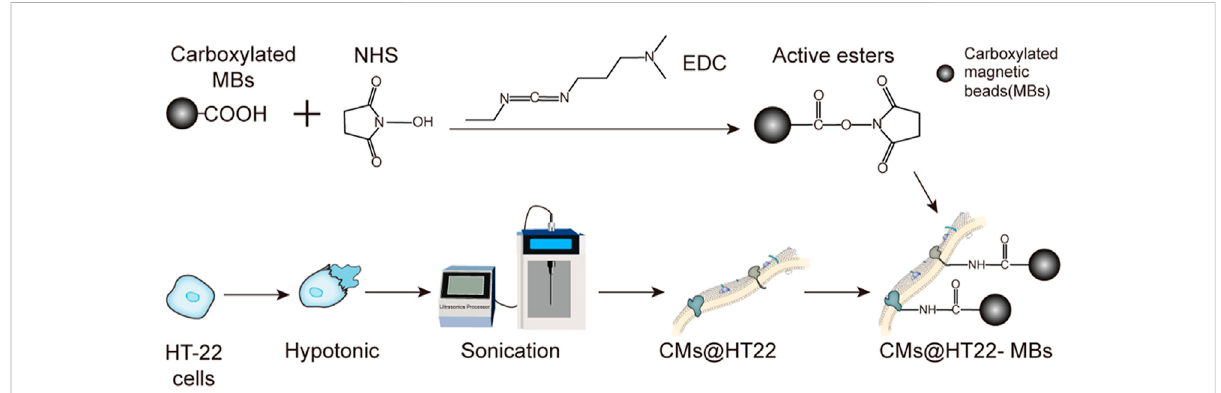
FIGURE 1 Preparation of membrane-coated magnetic beads (CMs@HT22-MBs). First, active esters were generated using the carboxylated magnetic nanoparticles through the reaction of EDC and NHS. Then, pure HT-22 cell membranes (CMs) were prepared by cell lysis and multiple centrifugations.Finally,theactiveesterimmobilizedwiththemagneticnanoparticlesreactedwiththeabundantaminogroupsonthecellmembrane to form amide bonds, and a stable composite material was